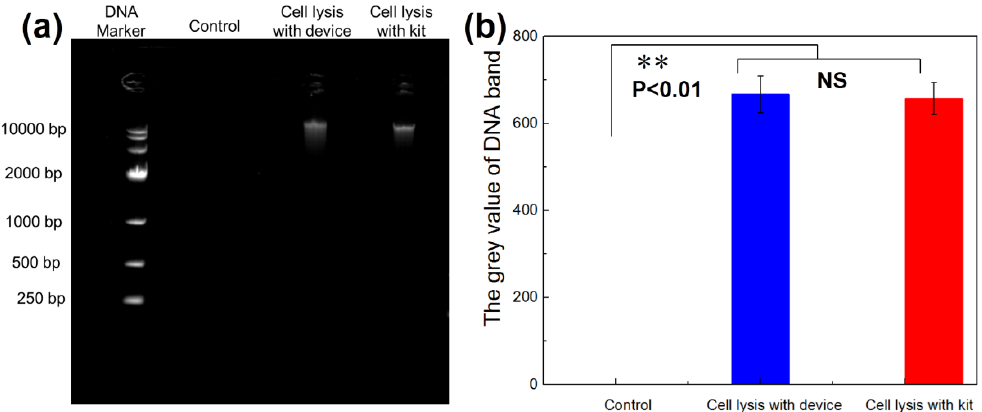
Figure 10. DNA gel electrophoresis of MCF-7 cells. ( a ) The control group, MCF-7 cells without ultrasound, shows no DNA band. The DNA band is observed by both the microfluidic device and commercial kit, indicating that the cells are cracked, and then the nucleic acids of the MCF-7 cells are released. ( b ) Semi-quantitative analysis of DNA production with Image J software. There is no significant difference between the results of the device and kit, but there is a significant difference compared to the control group.